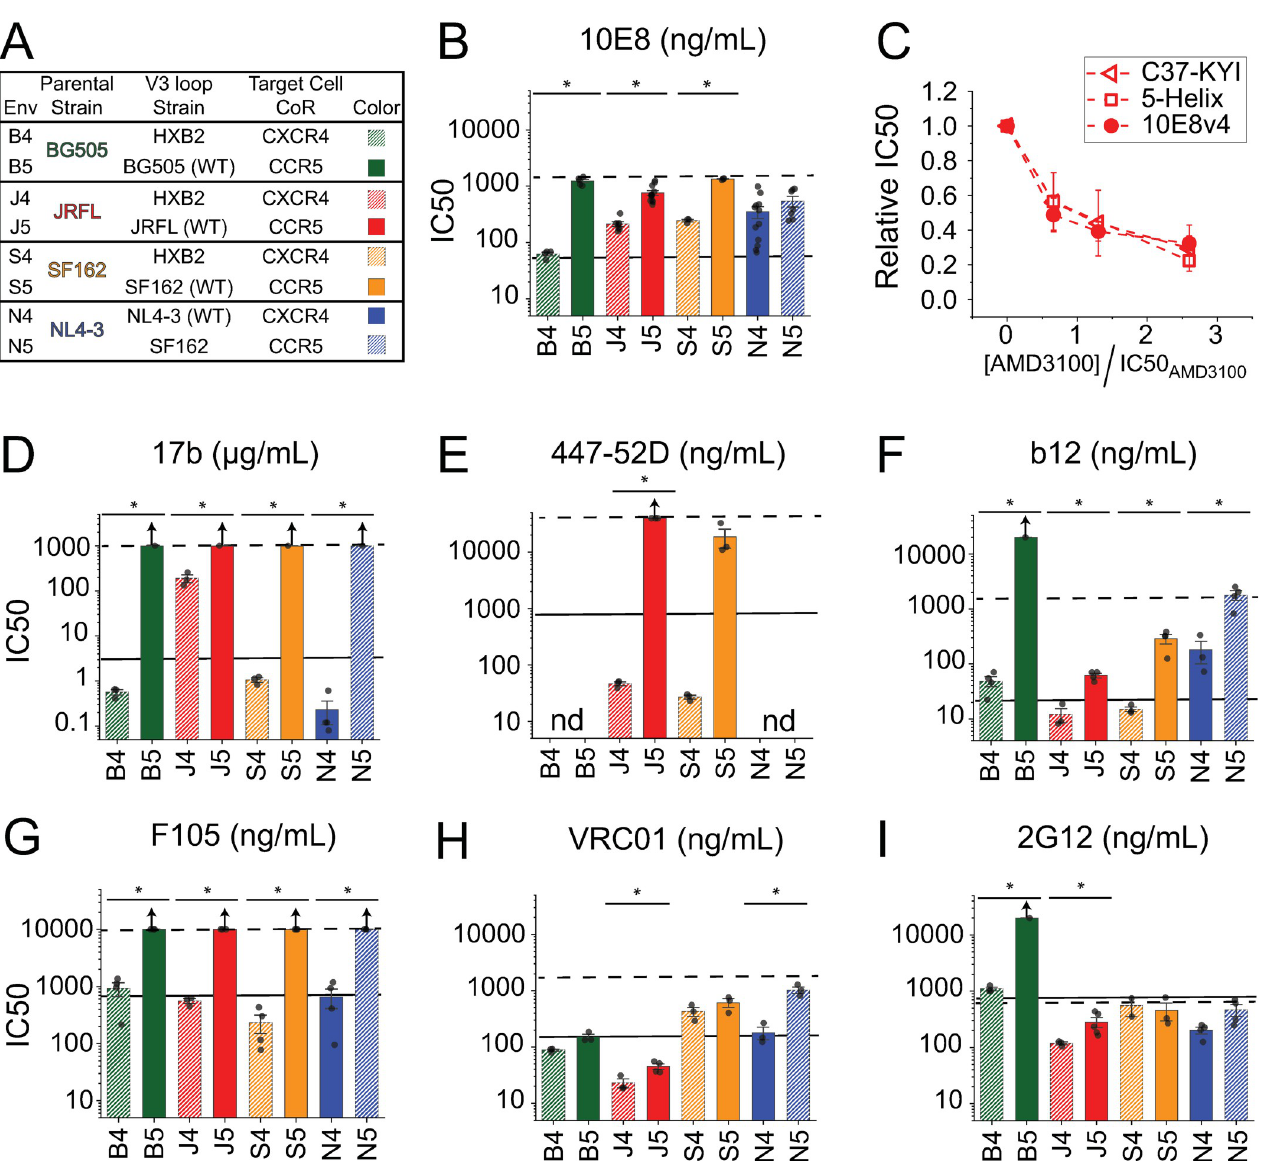
Fig 4. V3-loop swaps have variable effects on epitope exposure in other Env isolates. (A) Table listing the V3-loop strains of the tested Env variants. The Env HXB2 V3 loop was substituted into Env BG505 (green), Env JRFL (red) and Env SF162 (orange), while the Env SF162 V3 loop was substituted into Env NL4-3 (blue). (B) IC50 values determined for anti-MPER NAb 10E8 against wild type (solid) and chimeric (hatched) Envs. ( C ) Dependence of C37-KYI, 5-Helix and NAb 10E8 inhibitory potencies on CoRA AMD3100 concentration for J4 Env, the Env JRFL V3-loop chimeric variant. Data are normalized to the IC50 values obtained in the absence of CoRA. Note that CoRA concentration is expressed relative to the AMD3100 IC50 for J4 Env (61 nM). ( D-I ) IC50 values determined for anti-bridging sheet NAb 17b ( D ), anti-V3-crown NAb 447-52D ( E ), anti-CD4 binding site NAbs b12( F ), F105 ( G ) and VRC01 ( H ), and anti-glycan NAb 2G12 ( I ). In B and D-I , the solid and dashed black lines indicate the mean IC50 values measured against H4 and H5 Envs, respectively. Bars represent the mean ± SEM from three or more independent experiments. Arrows above the bars indicate that 50% neutralization was not achieved at the highest concentrations tested. Asterisks indicate significance as determined by a two-sample t-test (equal variance not assumed) with p < 0.05. In C , data points represent the mean ± SEM from four independent experiments; there was no significant difference between the three data sets (two-way ANOVA, p > 0.4). In E , “nd” denotes not